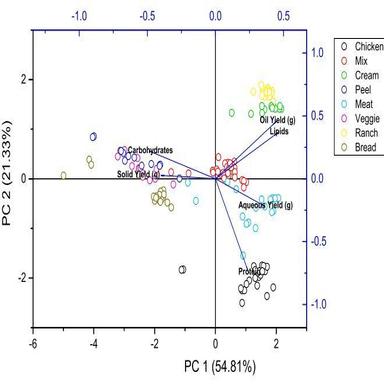
Principal component analysis (PCA) correlating feedstock compositions to HTL products yield. The various colors represent the different feedstocks and the total HTL reaction conditions (280–360C; 10–60 min).